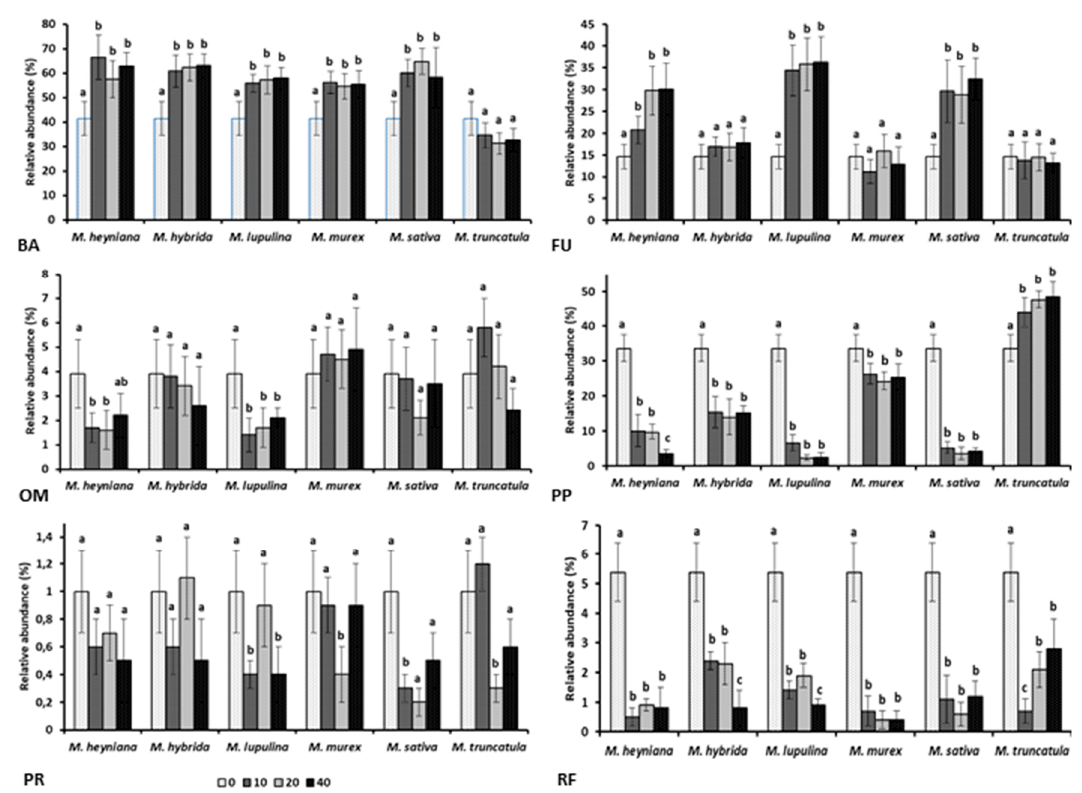
Figure 2. Relative abundance of the different nematode trophic groups in soil amended with 10, 20, or 40 g kg − 1 soil rates of dry plant biomass from six different Medicago species. BA = bacterivores; FU = fungivores; OM = omnivores; PP = plant parasites; PR = predators; and RF = root fungal feeders.